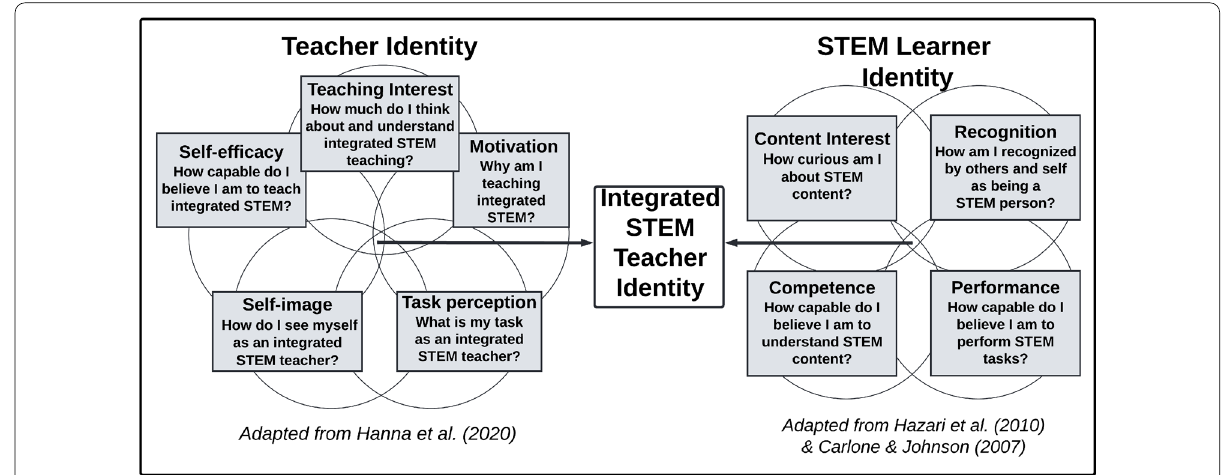
Fig. 3 Theoretical model of integrated STEM teacher